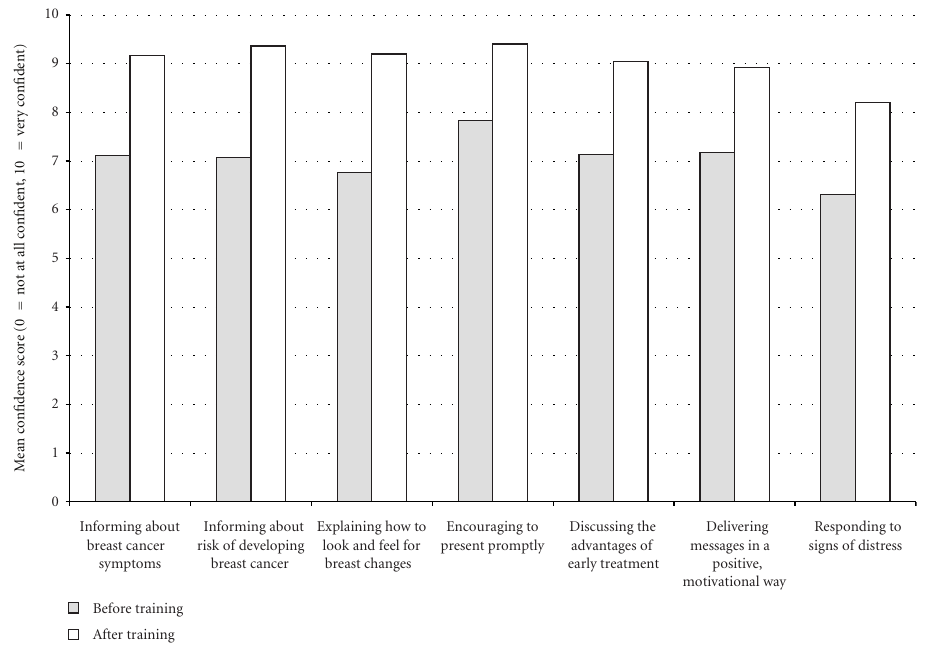
Figure 1: Mammographers’ mean confidence scores before and after